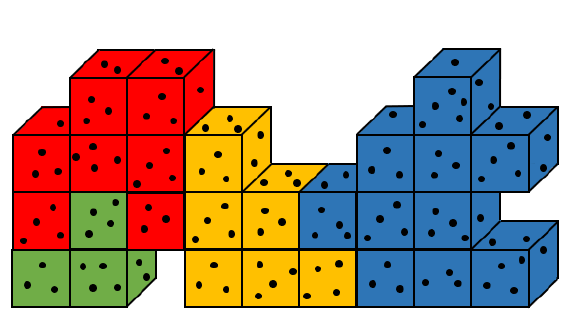
Figure 1. Representation of voxels (different cubes) and supervoxels (different colours) containing the original point cloud (dots)